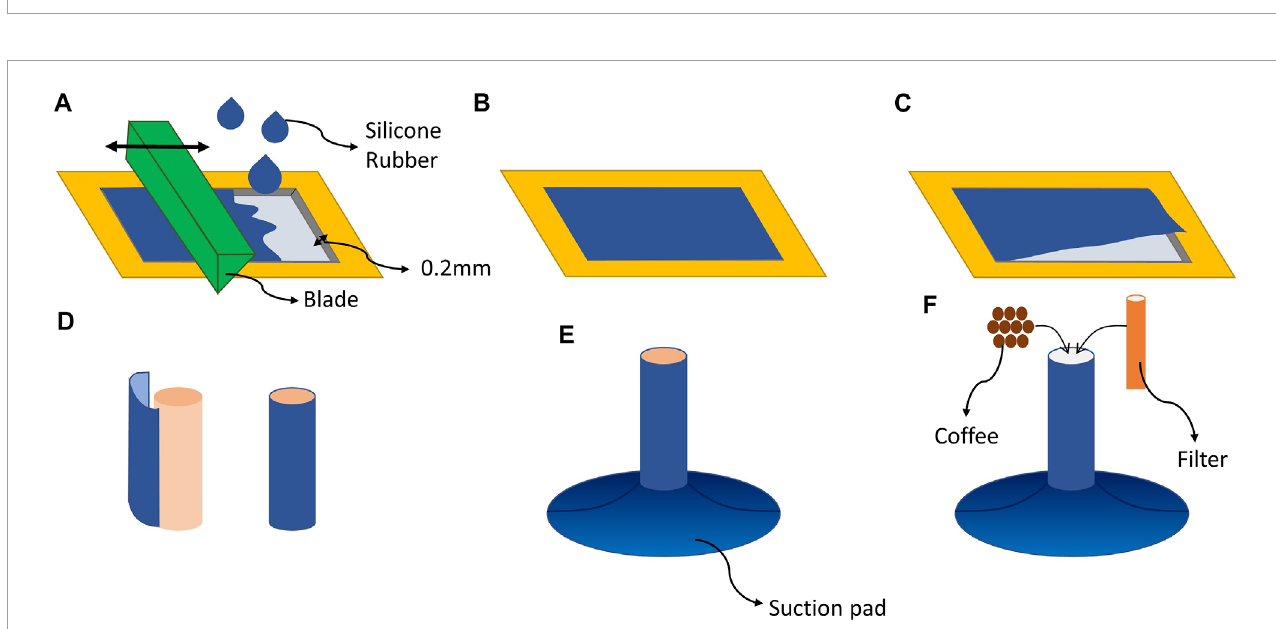
FIGURE 2 (A) Casting silicone rubber on a plate and using a sharp blade to make uniform thin film. (B) The silicone rubber cast on the plate and left to be cured. (C) Peeling the film from the plate (D) making a thin film stalk by wrapping the film around a cylinder and sealing the two edges of the film. (E) Attaching the suction pad to the stalk. (F) Adding coffee and placing the filter in the suction cup.